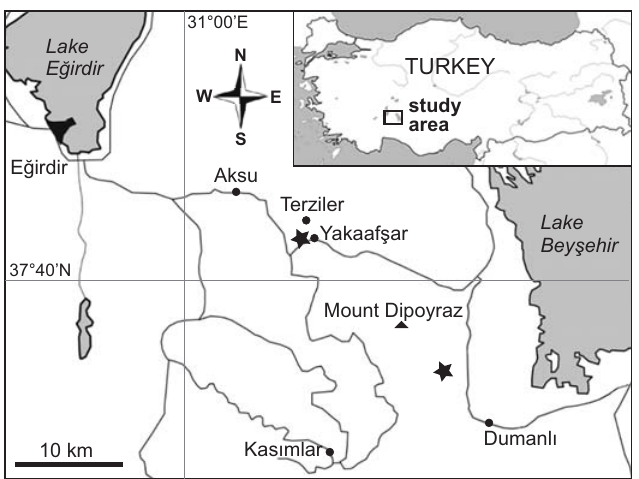
Fig. 1. Locality map of the Late Triassic seep deposits (stars), in southern Turkey, where the here described bivalves were found (from Kiel et al. 2017).